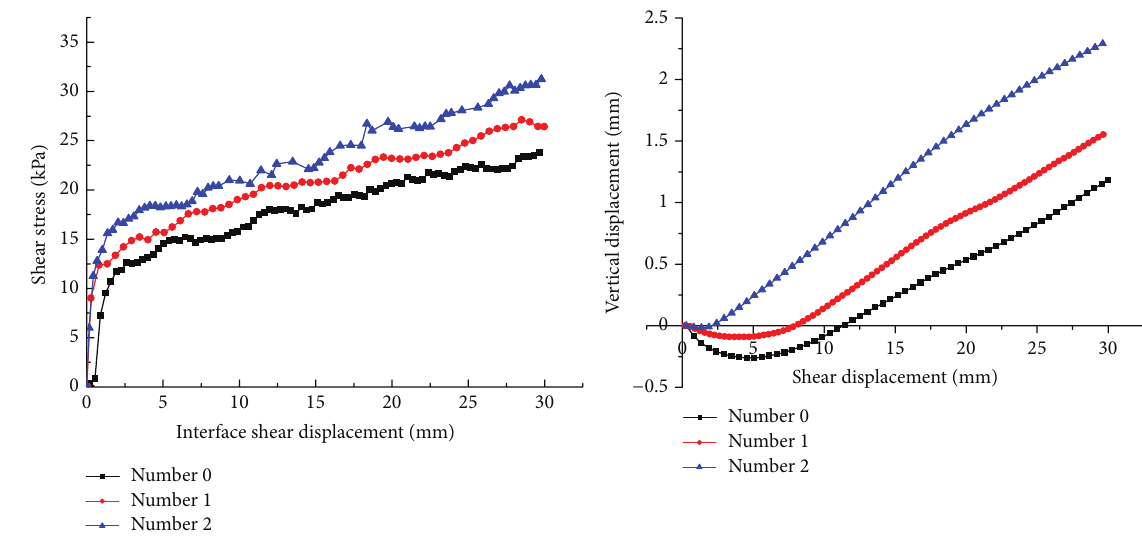
Figure 9: Test results for an interface not experiencing normal unloading (normal stress of 100kPa).